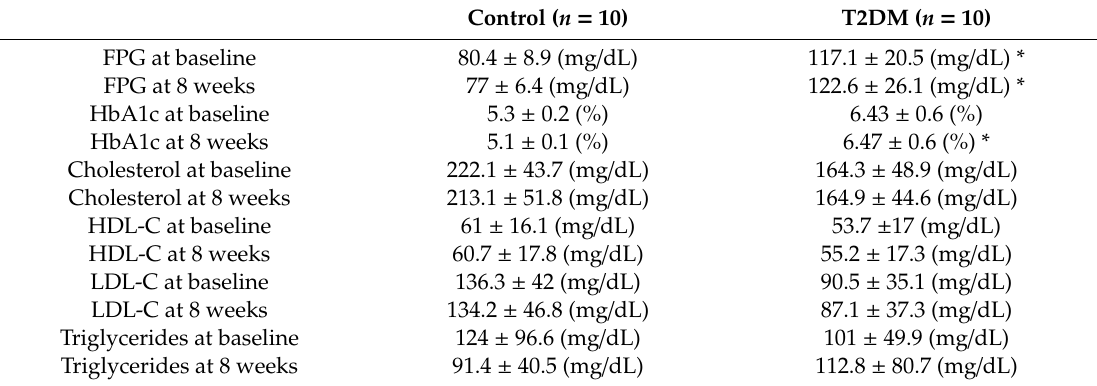
Table 2. Comparison of lipid profile of control and T2DM groups. Only fasting plasma glucose (FPG) and HbA1c showed significant di ff erence ( p <